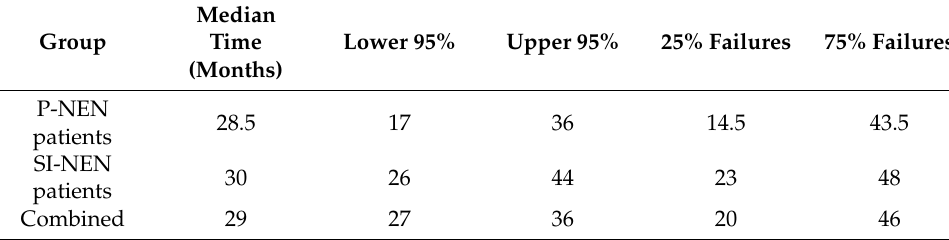
Table 2. Kaplan–Meier analysis of progression-free survival between P-NENs and